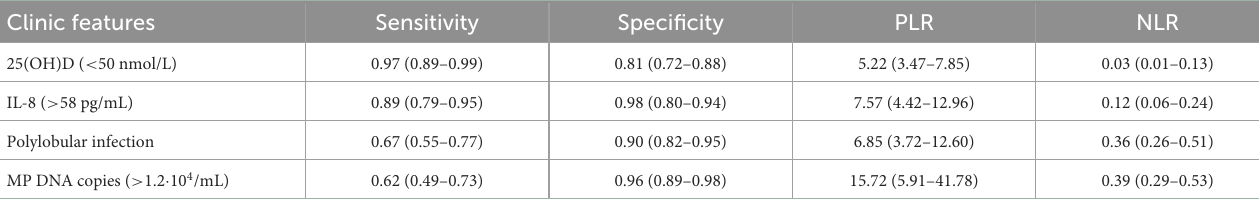
TABLE 5 Sensitivity and specificity of independent clinical characteristics for BMPs in children with MPP. Clinic